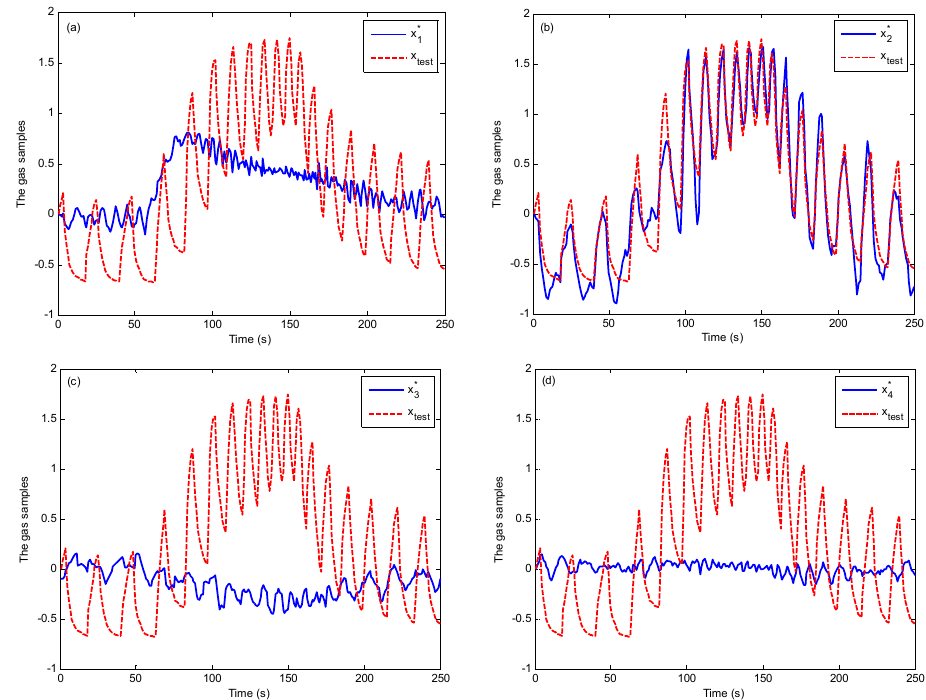
Figure 4. The original testing sample and four reconstrcted samples for 1000 ppm methane ( a ) The original testing sample